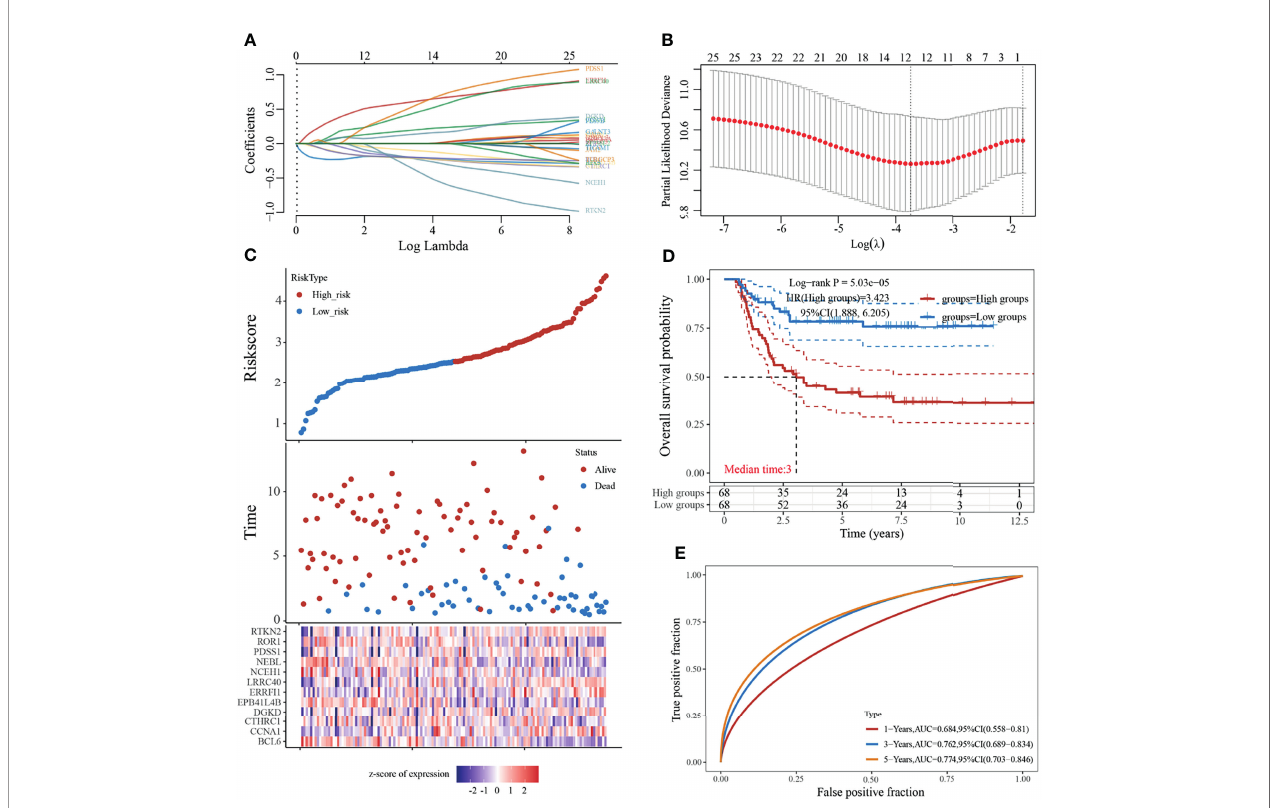
FIGURE 4 | Construction of prognostic risk model. (A) Coef fi cients of selected features are shown by lambda parameter; (B) Partial likelihood deviance versus log ( l ) was drawn using the LASSO Cox regression model; (C) Risk score, survival time, and survival status in dataset; (D) Kaplan – Meier survival analysis of the gene signature; (E) Time-dependent ROC analysis of the gene